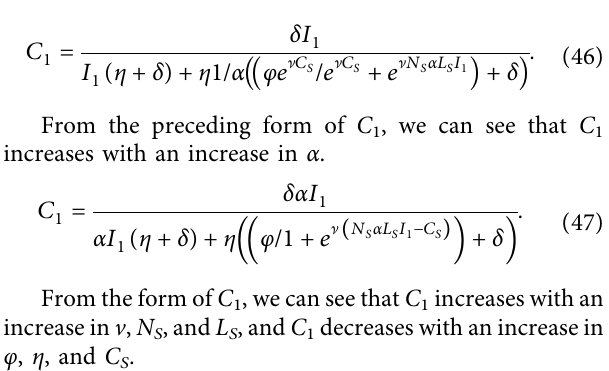
� 0.03, c � 0.1, ϕ � 0.6,